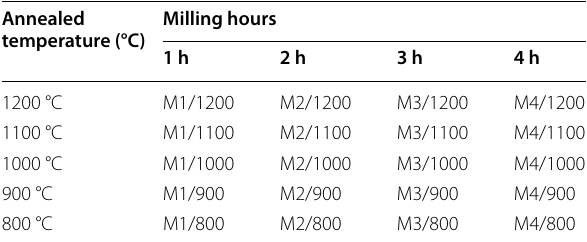
Table 1 Labelling of samples based on different milling